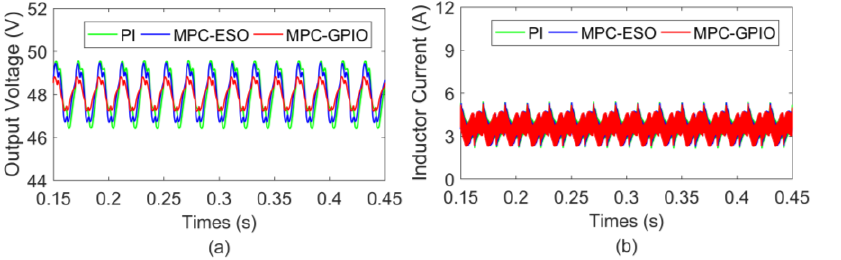
Figure 6. Dynamic response of TIBC with the input voltage, V in = 24 + 2sin ( 100 π t ) V : ( a ) output voltage; ( b ) inductor current.